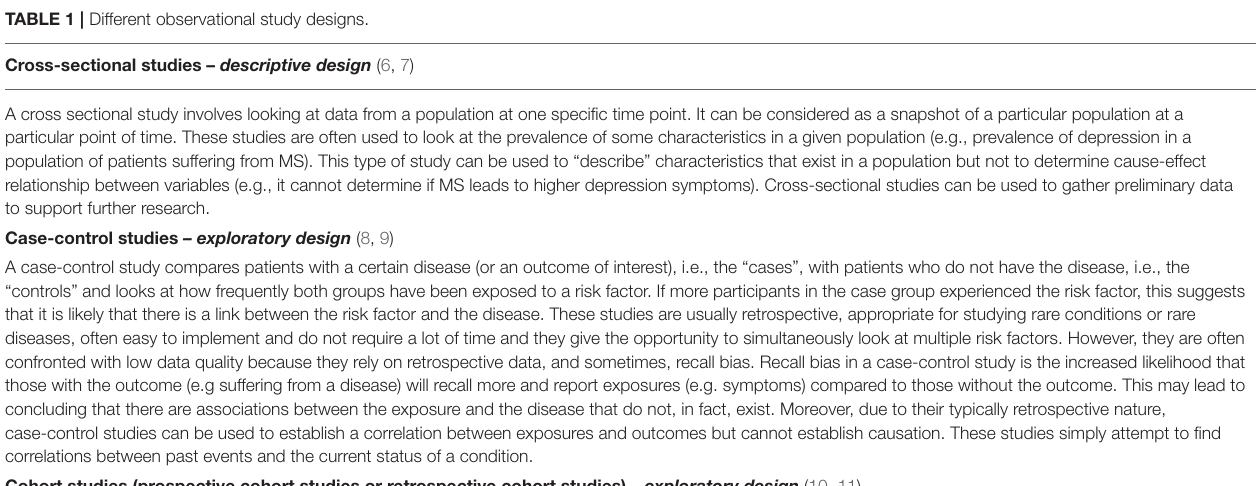
TABLE 1 | Different observational study